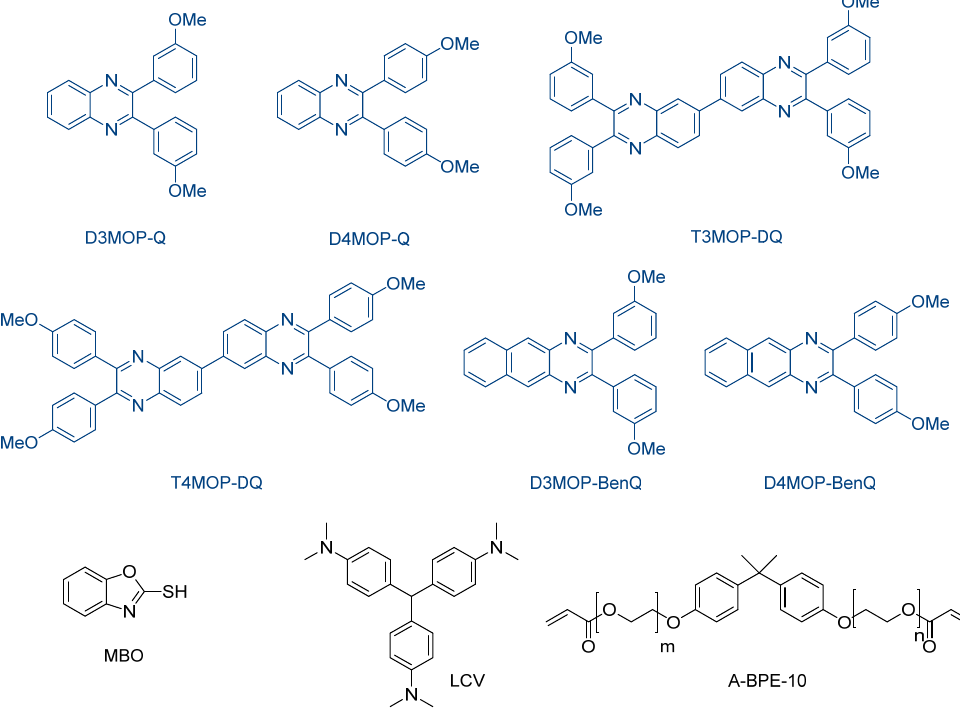
Figure 27. Chemical structures of MOPQs, different co-initiators and A-BPE-10.